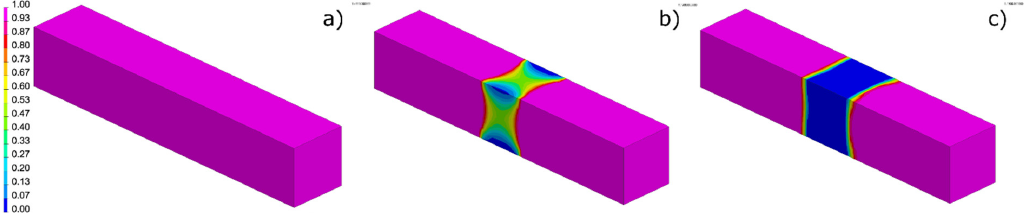
Figure 9. The calculated initial phase distributions (bainite–ferrite) for a thermal cycle with a maximum temperature equal to: ( a ) 400 °C, ( b ) 900 °C and ( c ) 1200 °C (Table 6).